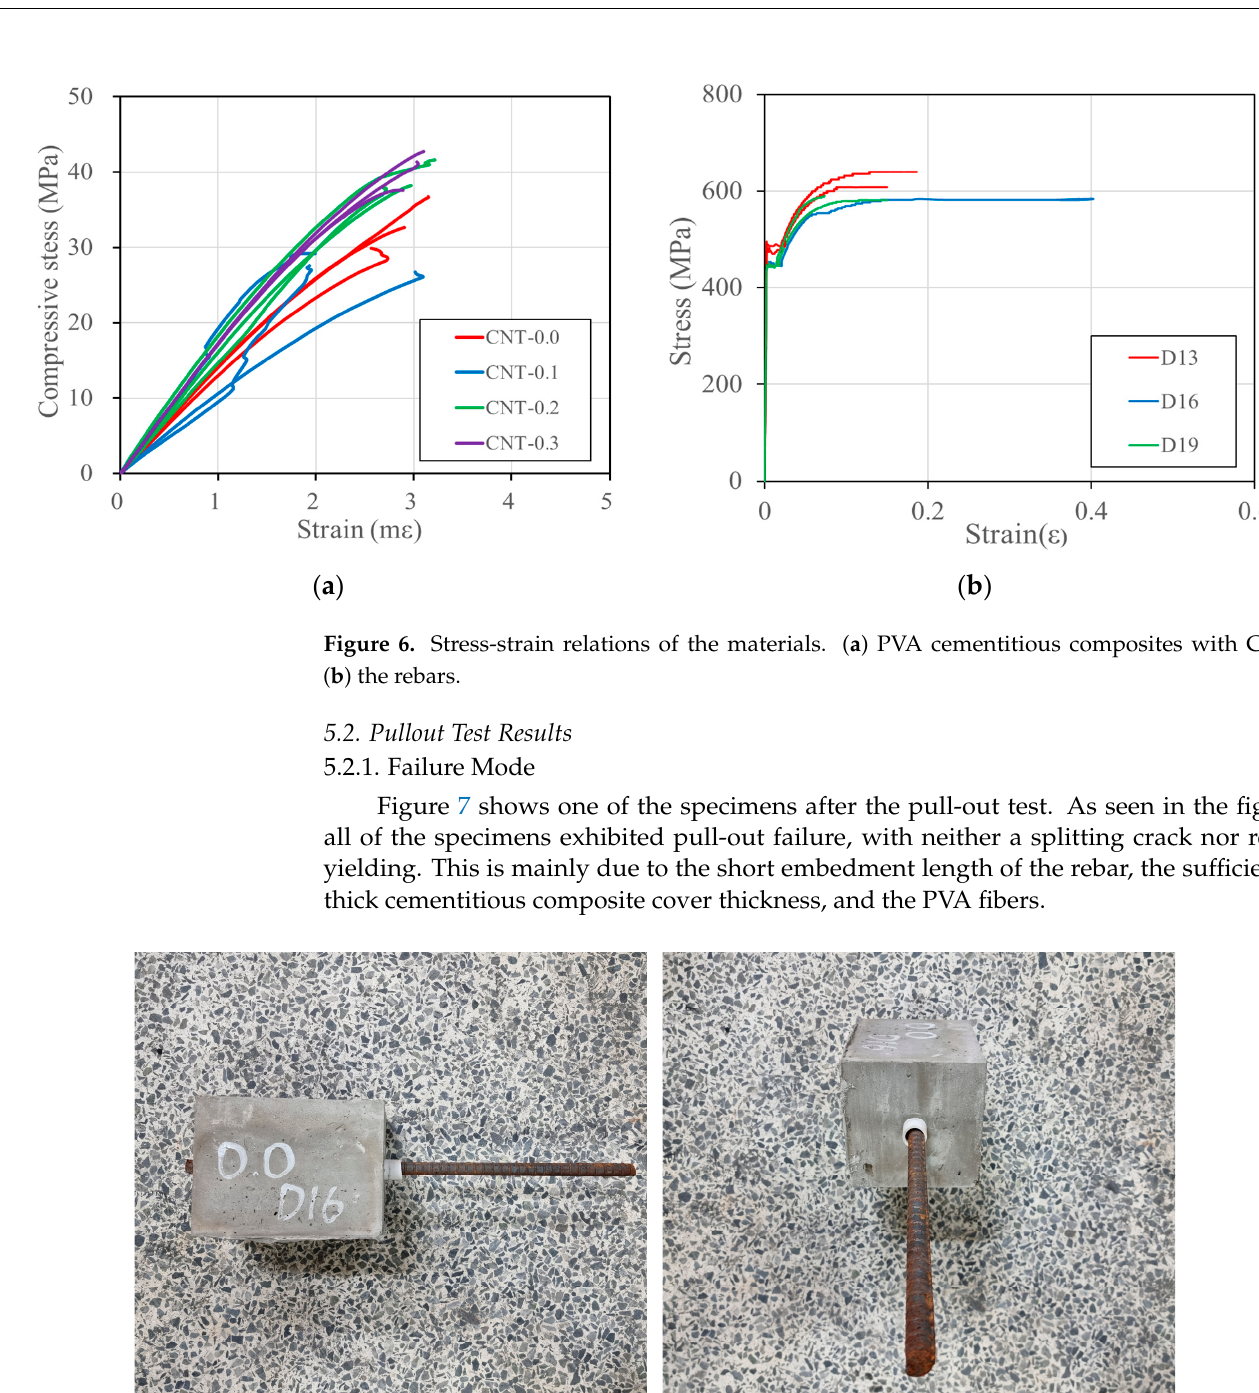
Table 6. Summary of the compression test results.